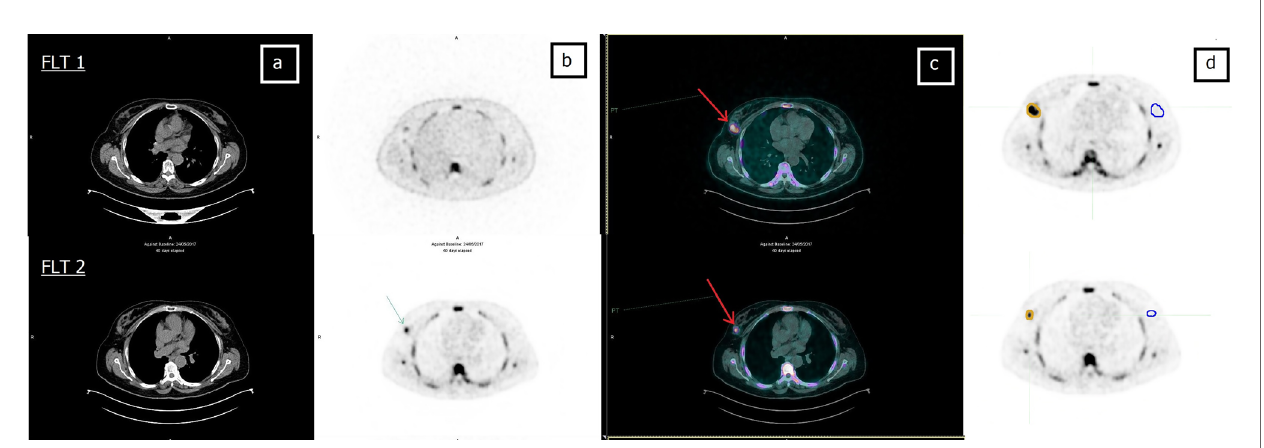
FIGURE 2 | Sixty-one-year-old patient (patient 6 in Table 2 ) undergoing NCT for locally advanced right BC. (A) CT, (B) FLT-PET, (C) CT and FLT-PET fusion, and (D) delineation of lesion (yellow line) and controlateral breast (blue line). Upper row: FLT 1; lesion SUV max = 9.1. Bottom row: FLT 2; lesion SUV max = 5.6. Red arrow indicates breast lesion. Post mastectomy histological examination revealed the absence of neoplastic tissue. EORTC PET classi fi cation: PR (partial remission).